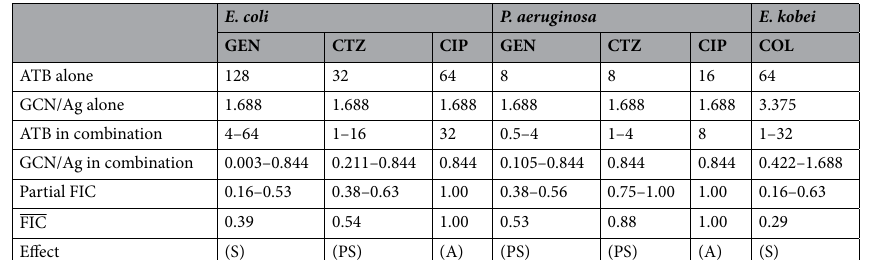
Table 2. Minimum inhibitory concentrations MIC [mg/L] a of various antibiotics and the GCN/Ag nanohybrid, average FIC b values for combinations of antibiotics with the GCN/Ag nanohybrid, and the resulting antibacterial effects. a The MIC determination is a qualitative assay and the estimated error is of the order of magnitude of the value; (n = 3). b Average value (SD); (n = 3). *(S) synergy, (PS) partial synergy, (A) additive. **GCN/Ag shows silver related concentration. ***The ranges given in the ATB in combination row of this table indicate the ranges of MICs obtained for the indicated antibiotic when applied with varying concentrations of the GCN/Ag nanohybrid. Similarly, the ranges given in the GCN/Ag in combination row indicate the ranges of MICs obtained for the nanohybrid when applied in combination with varying concentrations of the indicated